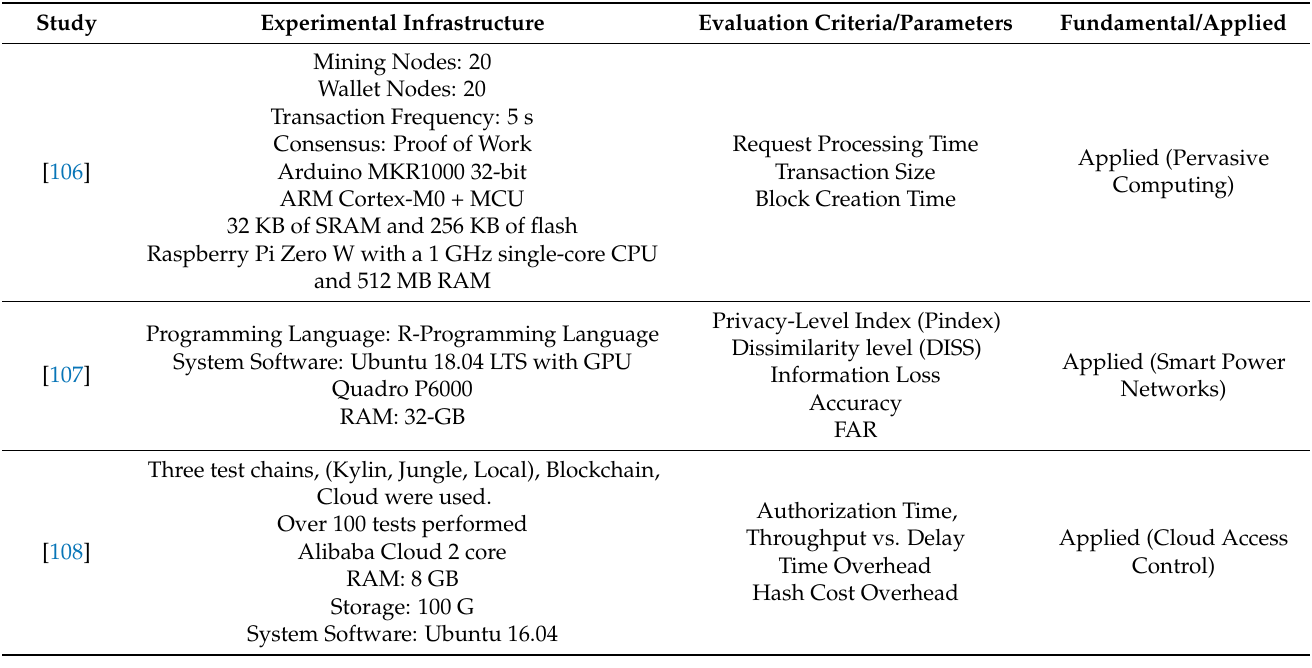
Table 4. Summary of state-of-the-art blockchain privacy evaluation parameters. Evaluation